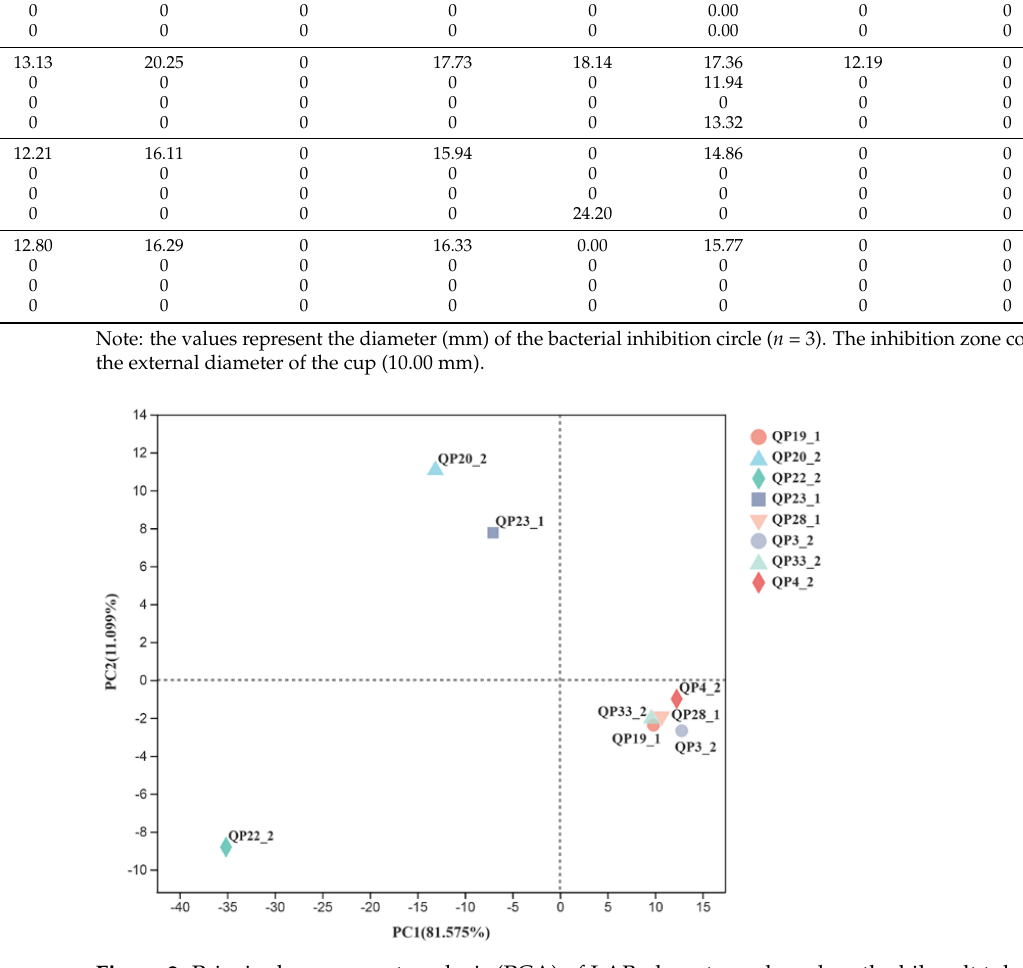
Figure 2. Principal component analysis (PCA) of LAB phenotypes based on the bile salt tolerance, gastrointestinal tract (GIT), hydrophobicity, auto − aggregation, and antimicrobial activity.